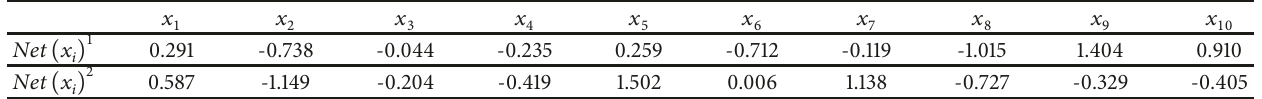
Table 6: The value of probability of alternative 𝑥 𝑖 under different dimensions.